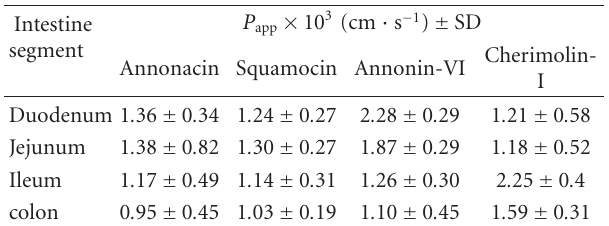
Table 4: The permeability ( P app , Mean ± SD, n = 6) at di ff erent site of